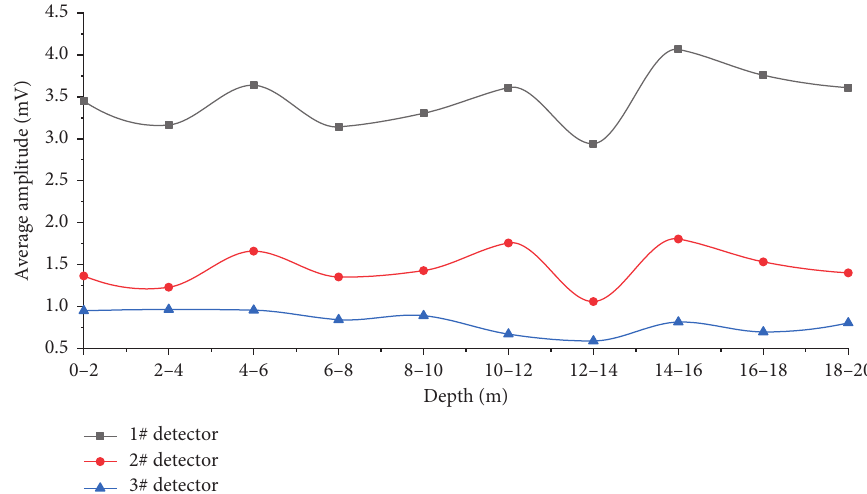
Figure 7: Variation curve of the modified amplitude value with drilling depth.